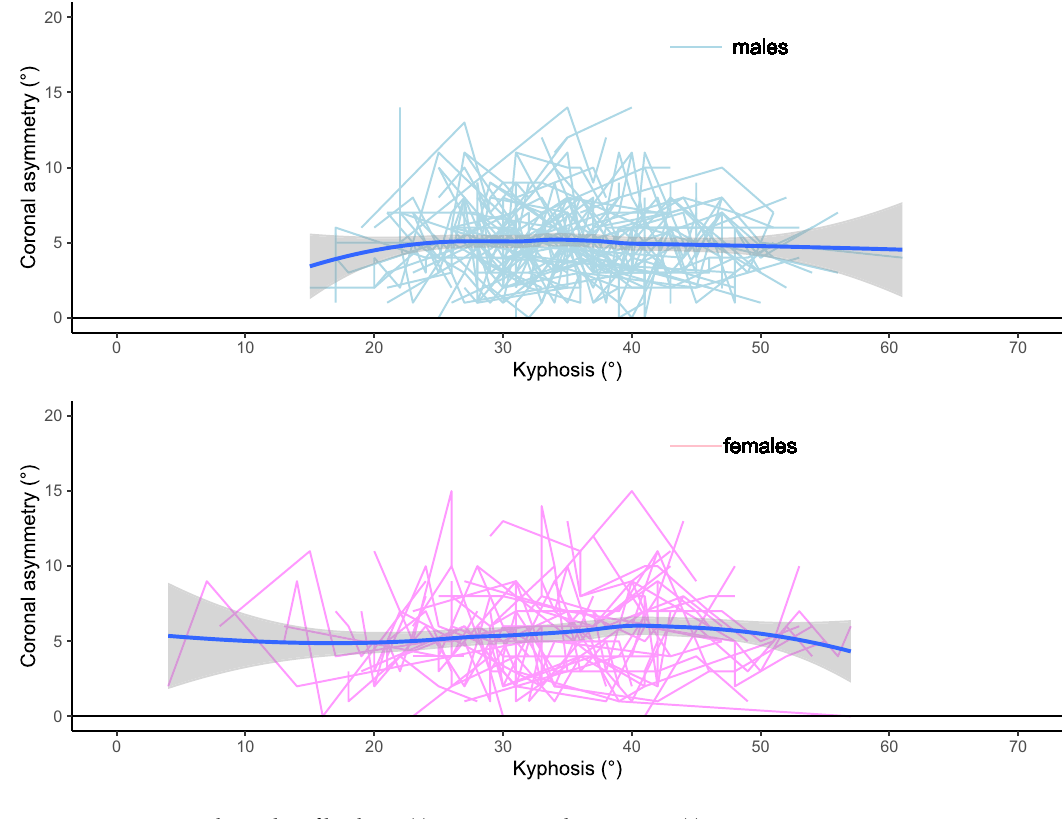
Figure 1. Spaghetti plot of kyphosis (°) against coronal asymmetry